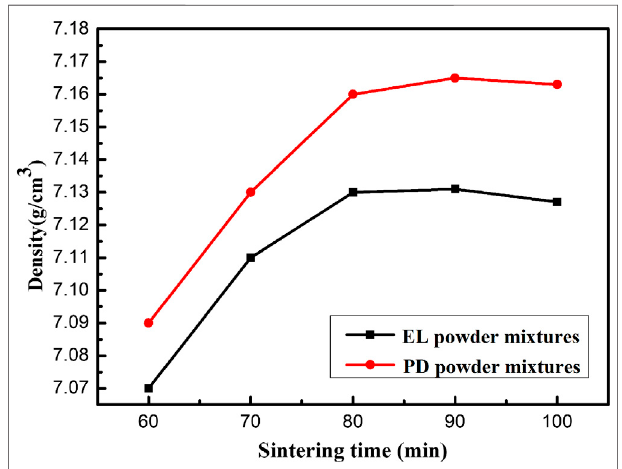
Frontiers in Materials |